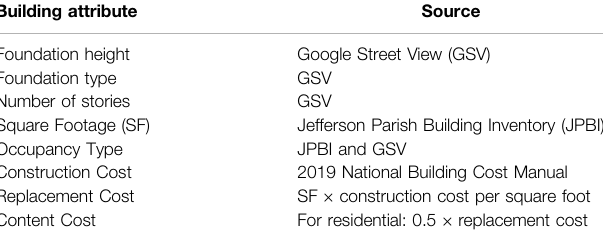
TABLE 3 | Sources of best available data